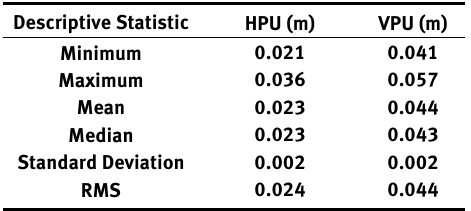
Table 4. Descriptive statistics for measured vs. reported quality